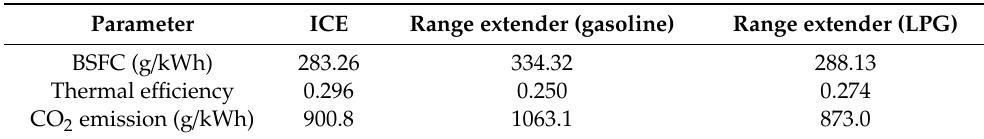
Table 6. BSFC, thermal efficiency, and CO 2 emission for the ICE and range extender operating at maximum power.